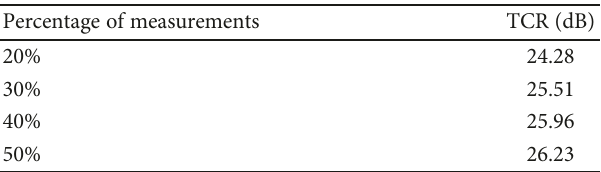
Table 3: TCR of the NUFFT-based SPGL1 algorithm for di ff erent percentages of measurements.